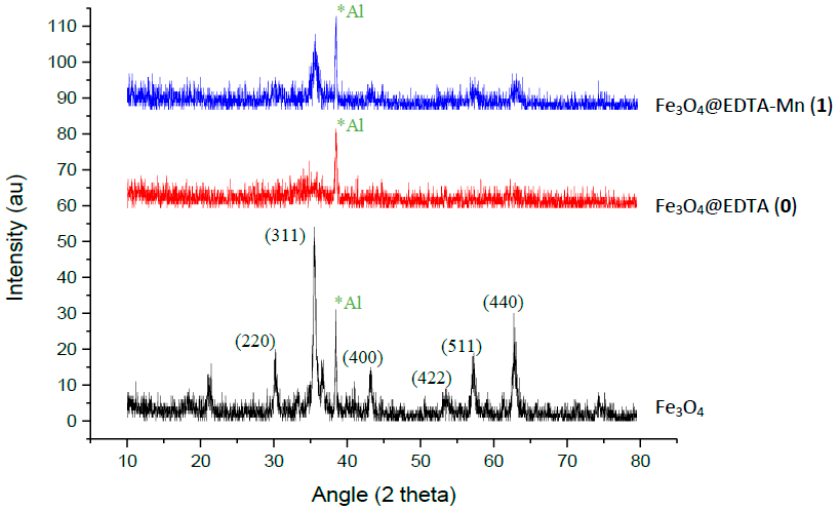
Figure 2. X ‐ ray diffraction patterns of Fe 3 O 4 , Fe 3 O 4 @EDTA ( 0 ) and Fe 3 O 4 @EDTA ‐ Mn 2+ ( 1 ) MNPs.